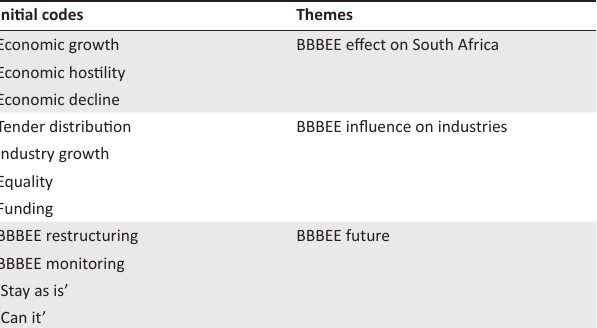
TABLE 3: Initial codes and themes. Initial